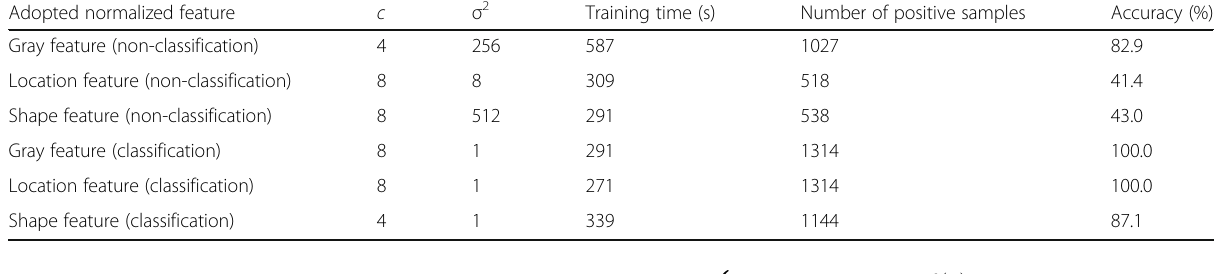
Table 1 Training results of six basic classifiers on penalty factor c and kernel function parameter σ 2 Adopted normalized